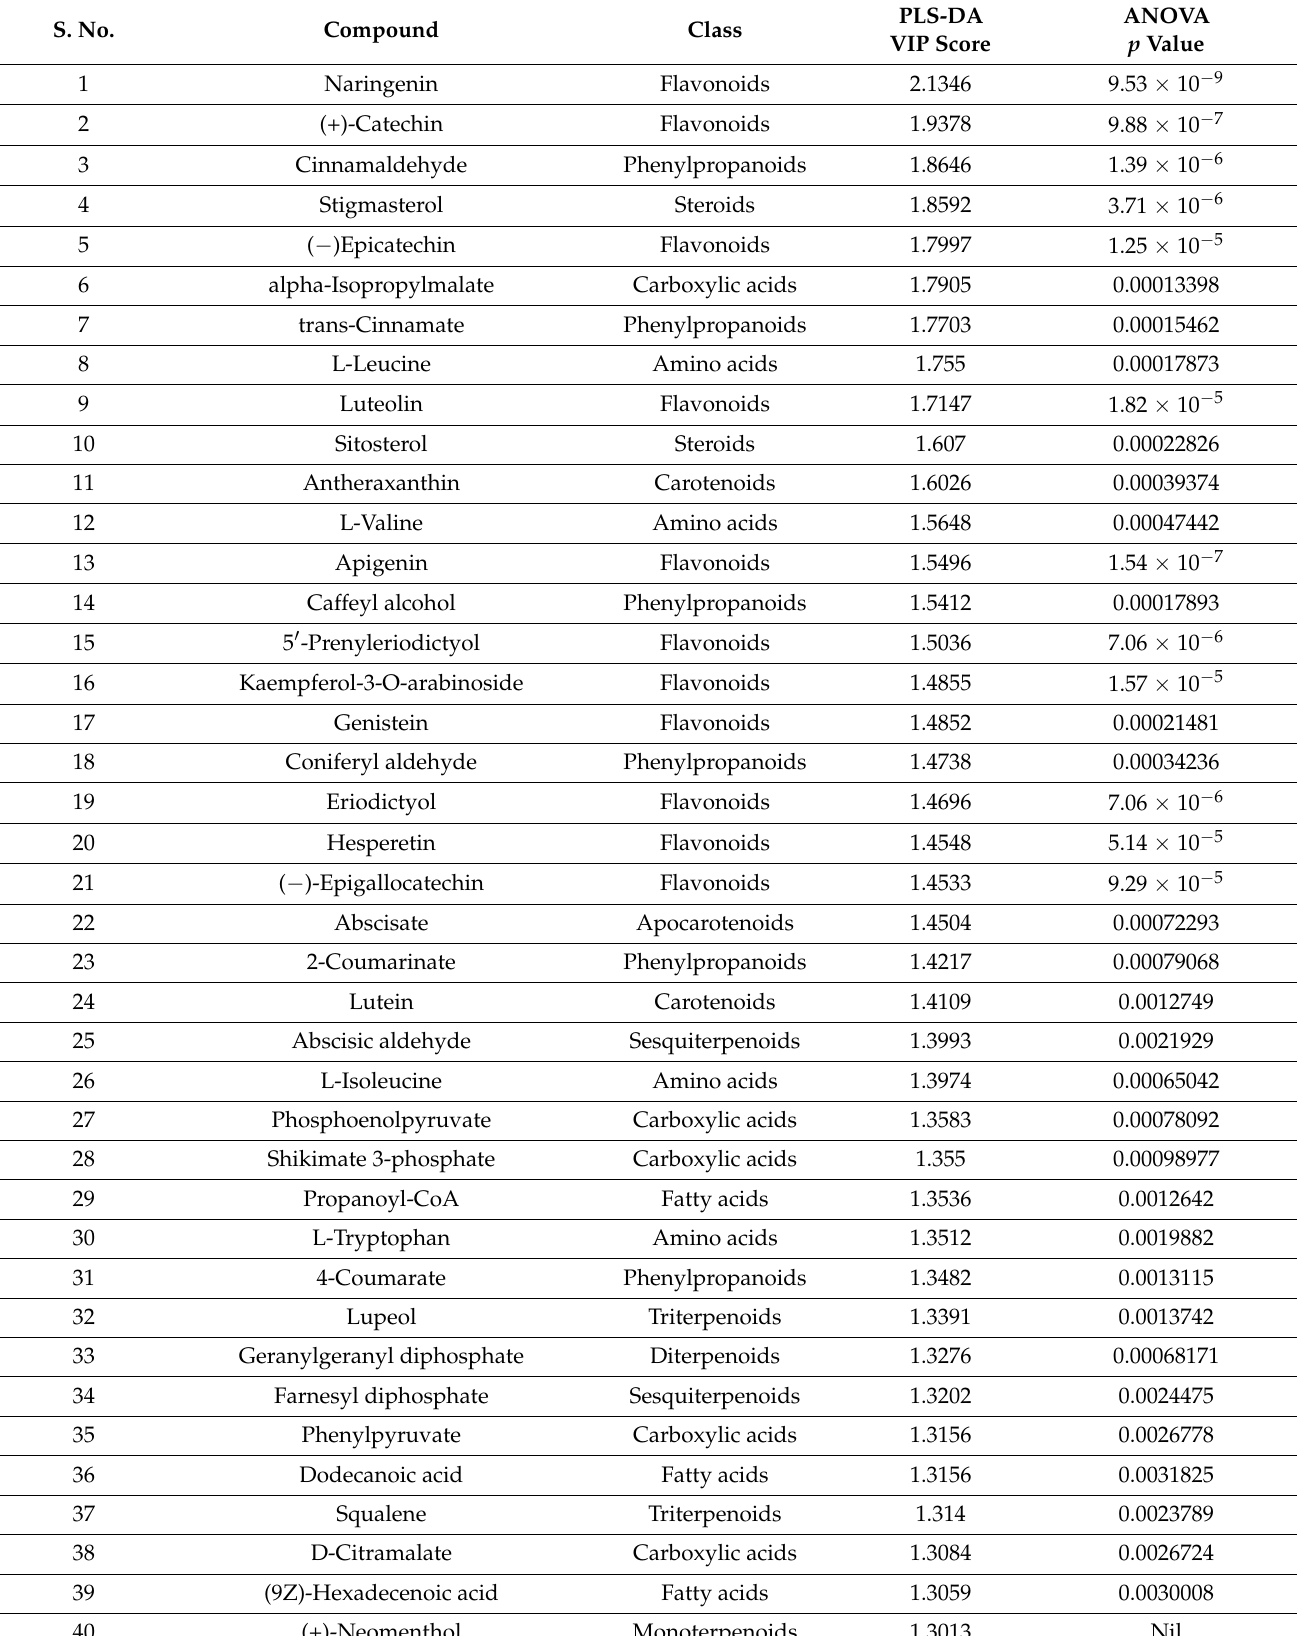
Table 1. List of significant metabolites differentiating diverse sorghum